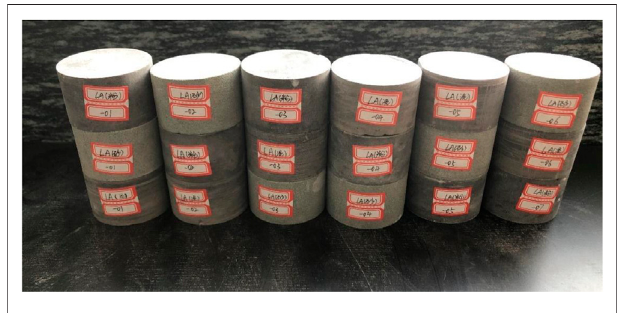
FIGURE 2 | Combination methods of different lithological surrounding rocks.